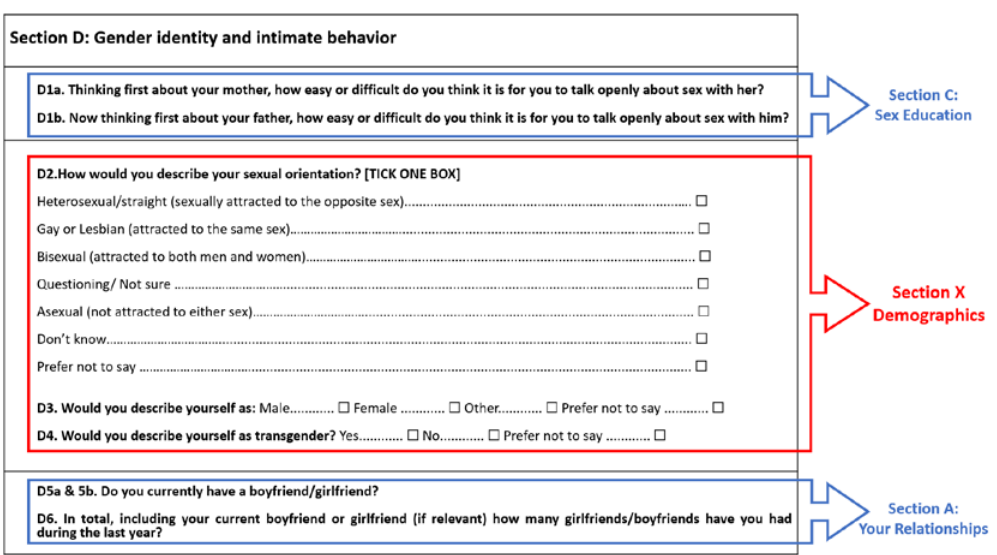
Figure 3. Realigning Section D questions with SOGI questions placed in Section X with demographic questions. graphic